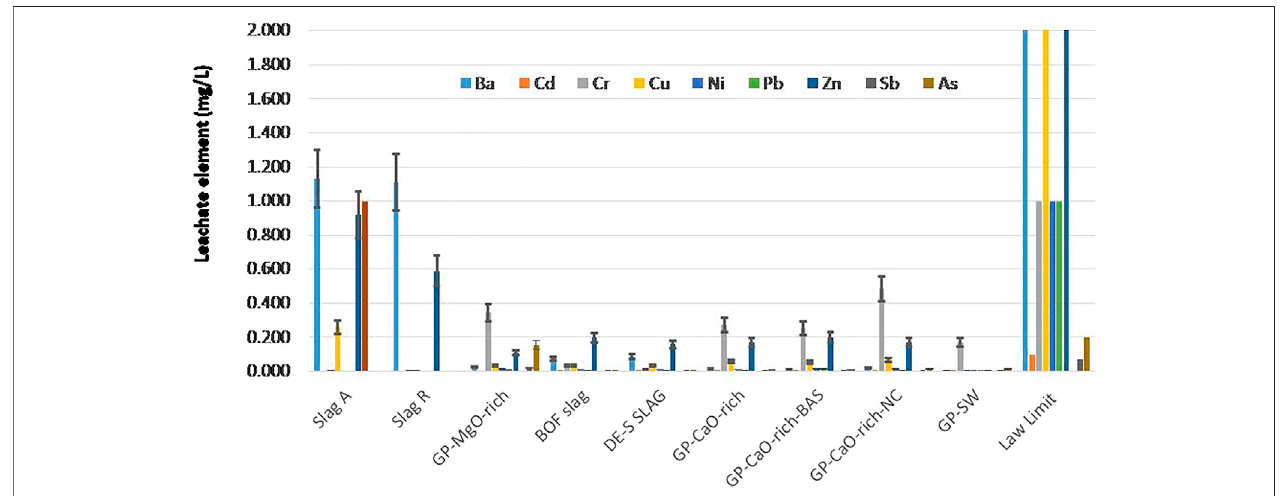
FIGURE6| ComparisonoftheleachateelementsfromthestartingslagsandSWwiththesameelementleachateoutfromthecorrespondingAAMs.Referencelaw limit values are taken from European Directive 1999/31/CE (https://eur-lex.europa.eu/legal-content/EN/TXT/PDF/?uri (cid:1) CELEX:31999L0031&from (cid:1) PL).